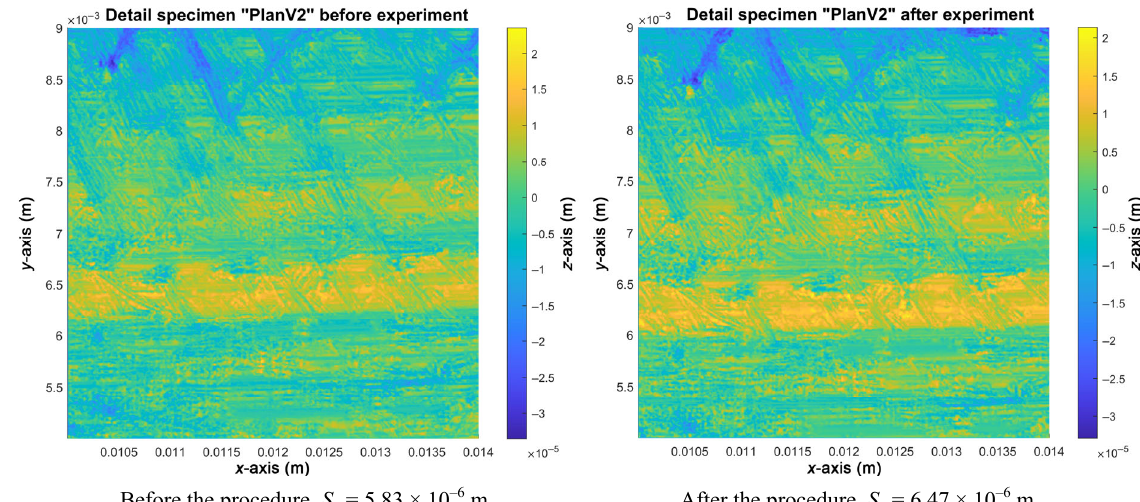
Fig. 5 Sections of the topographies of the finely filed specimen before and after the procedure.